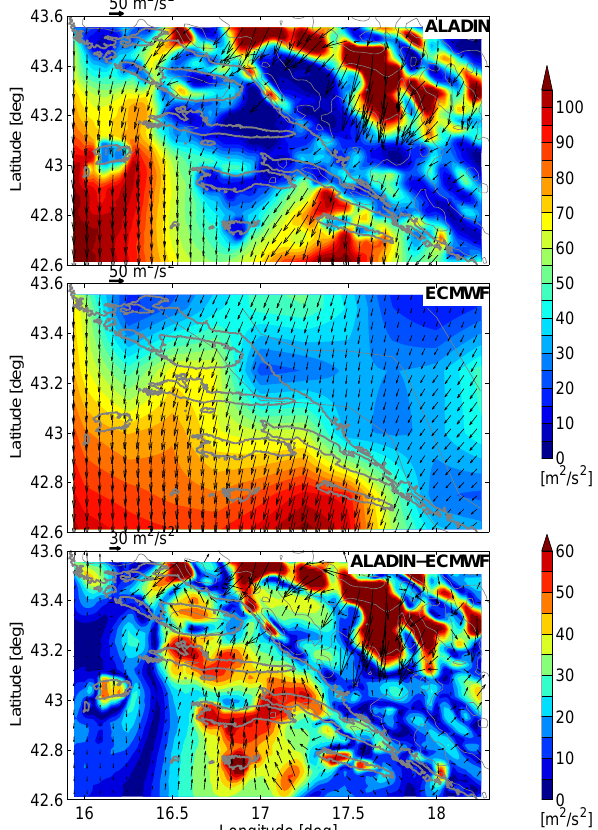
Fig. 2. Mean ALADIN (top panel) and ECMWF (center panel) modeled wind pseudo-stress for the B2 Bora episode (Table 1). The bottom panel shows the difference between these two. Addition- ally, the magnitudes of vector differences | ALADIN-ECMWF | are shown in colors. Topography contours, as seen from the models, and shore lines are indicated with thin and thick grey lines, respec-